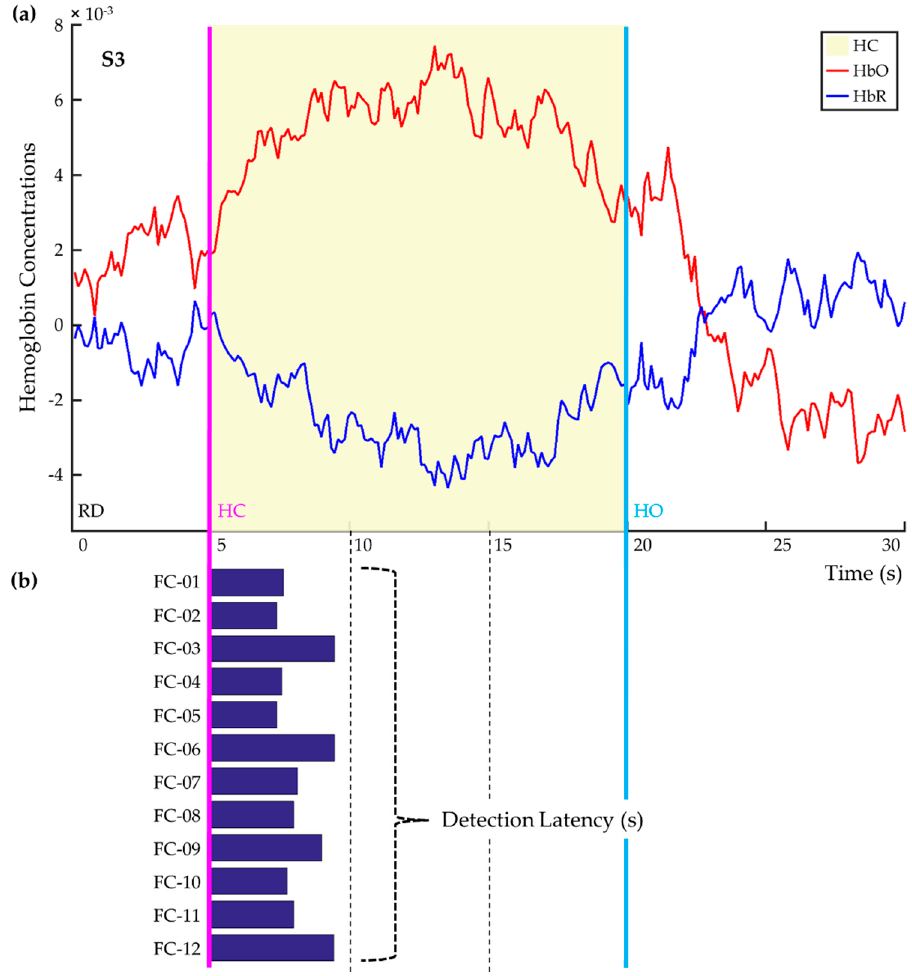
Figure 5. Hemodynamic Responses and Detection Latencies by Feature Vector Compositions (Participant ID: 3): ( a ) The hemodynamic responses of [HbO] and [HbR] during the hand-closing task. The responses are averages of all channels across all trials after preprocessing by moving average convergence/divergence (MACD); ( b ) Visual comparison of detection latencies for each of the 12 feature vector compositions.